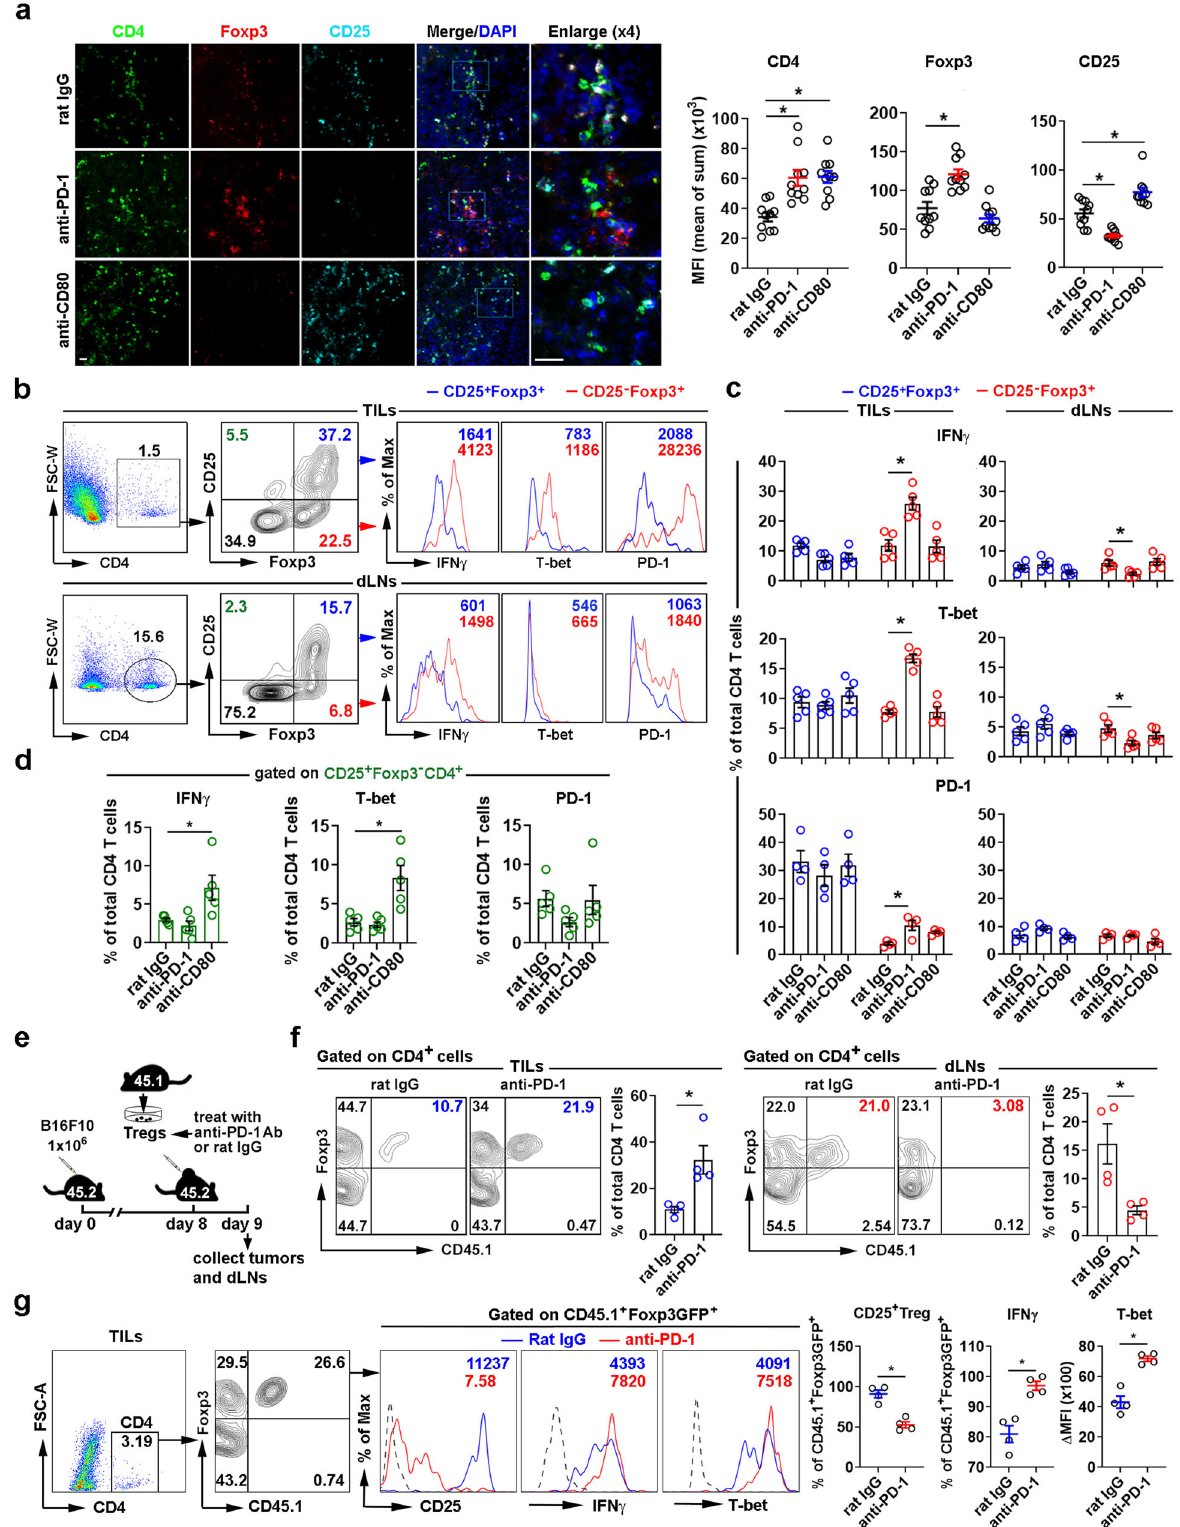
ZO-1 and the zipper junctional VE-cadherin remained. PD-L1 de fi ciency also upregulated Lyve-1 expression, the receptor of hyaluronan. Changes in each of these junctional and cell surface proteins could contribute to impaired T cell TEM. PD-L1 − / − LECs and lymphatic vessels also showed altered morphology compared to WT. These observations suggested endothelial